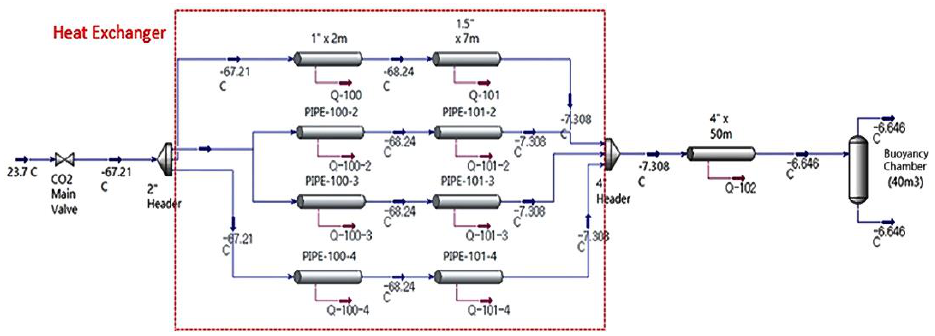
Figure 11. Example of pipe line diagram for when a heat exchanger is applied.